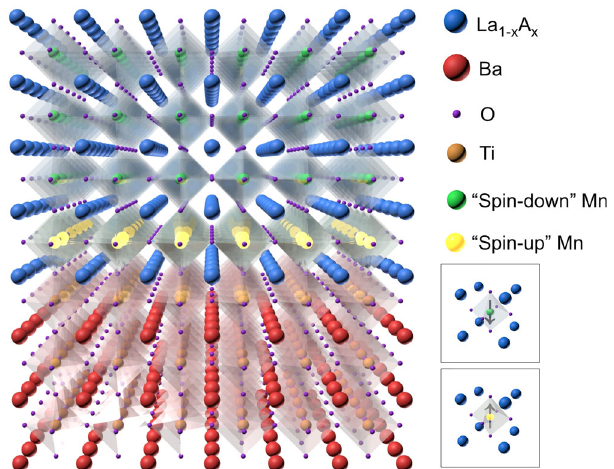
Fig. 6 Schematic of an electrically driven interface magnetic phase transition in a (La 1 − x A x )MnO 3 /BaTiO 3 interface. Electrically reversing the electric polarization in the BaTiO 3 layer can switch the magnetic moment of the interface Mn atoms by 180°, resulting in a ferromagnetic to AF phase transition occurring only at the interface. The oxygen octahedral rotations in these perovskite materials are not shown for simplicity. This mechanism was fi rst predicted by Burton et al.